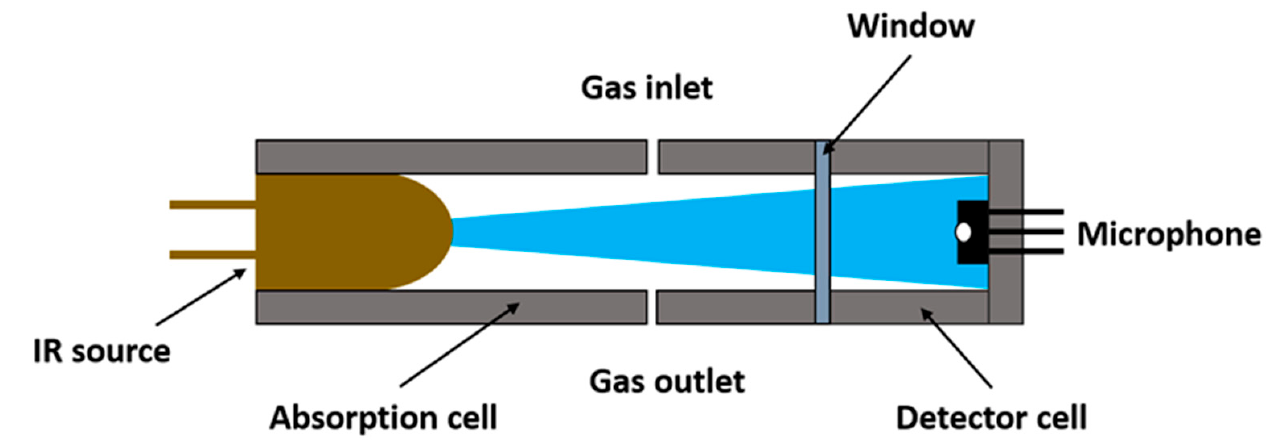
Figure 1. Scheme of a two-chamber photoacoustic sensor. The light of a modulated source passes through the absorption cell with an unknown target gas concentration. The detector cell with the microphone is hermetically sealed and filled with the target gas or a substituent. The detector signal decreases with an increasing target gas concentration in the absorption cell.